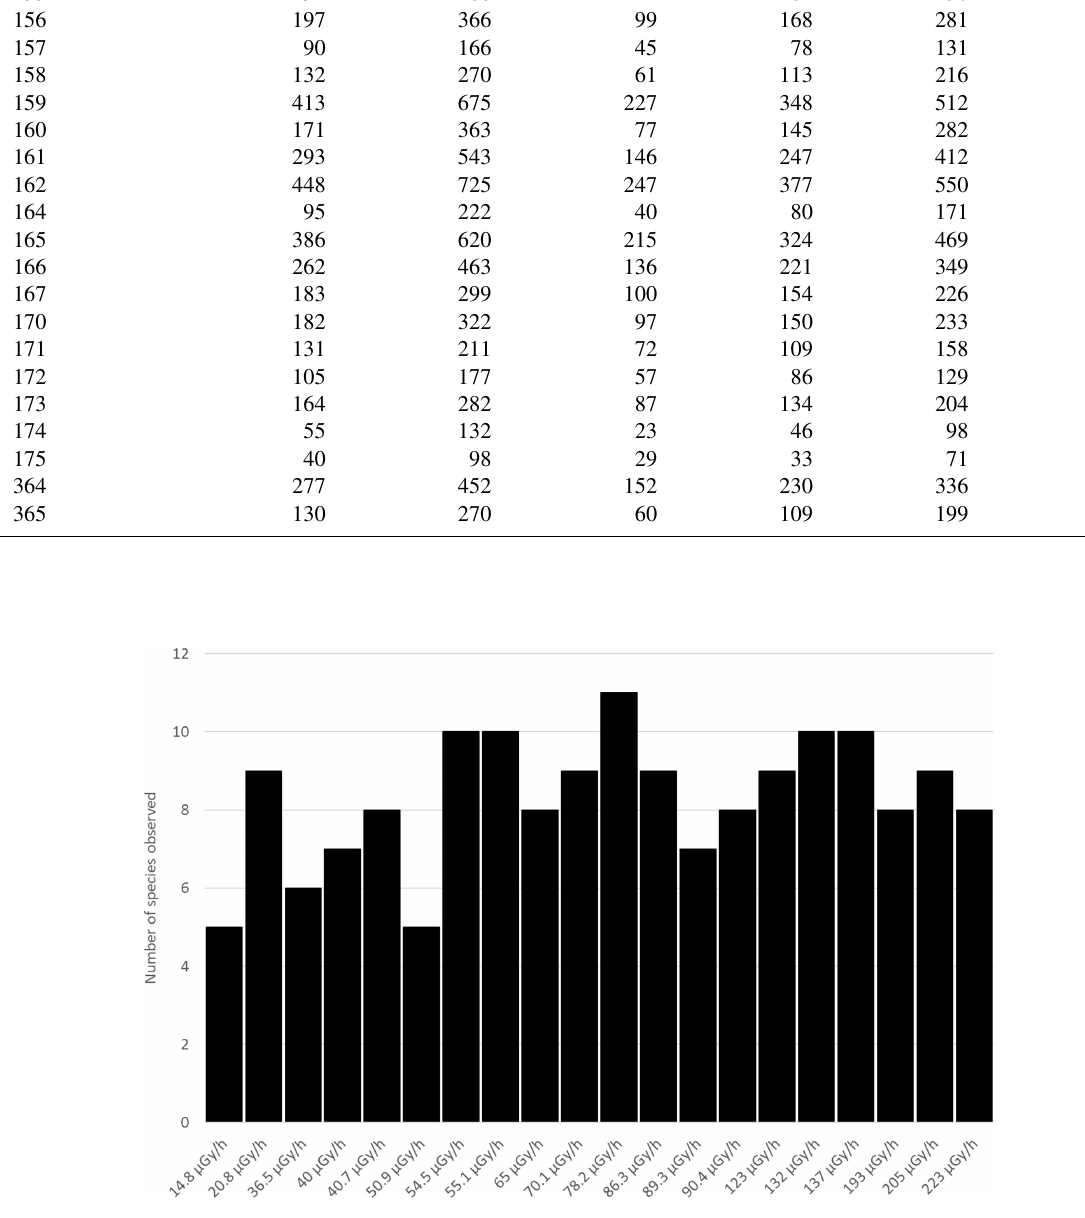
Figure 2. Number of species observed by estimated weighted absorbed dose rate (note the estimated weighted absorbed dose rates presented are those estimated for the geometry approximating to a red